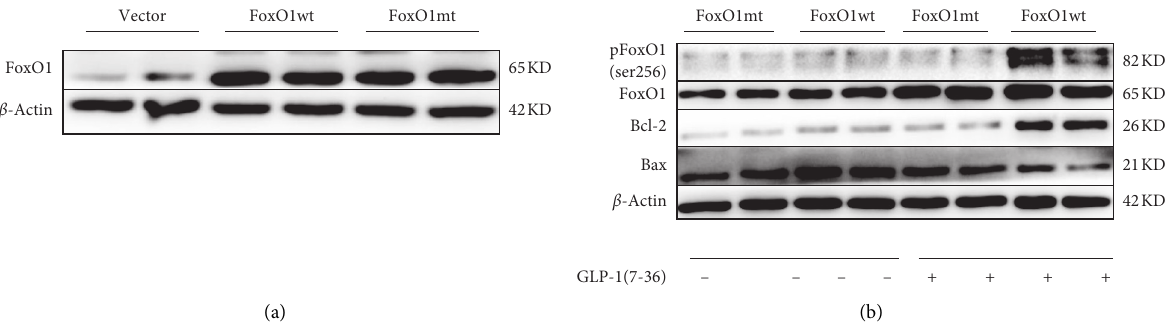
Figure 5: GLP-1 (7-36) protected PCOS MGCs by modification of forkhead box protein O1 phosphorylation sites. (a) FoxO1 was detected using their specific antibodies by the Western blot analysis for the PCOS MGCs after transfection. (b) FoxO1, pFoxO1 (ser 256), bcl-2, and bax were detected using their specific antibodies by the Western blot analysis for the PCOS MGCs treated with 100nM GLP-1 (7-36) for 48h after transfection as indicated in the figure legends. The experiment was repeated